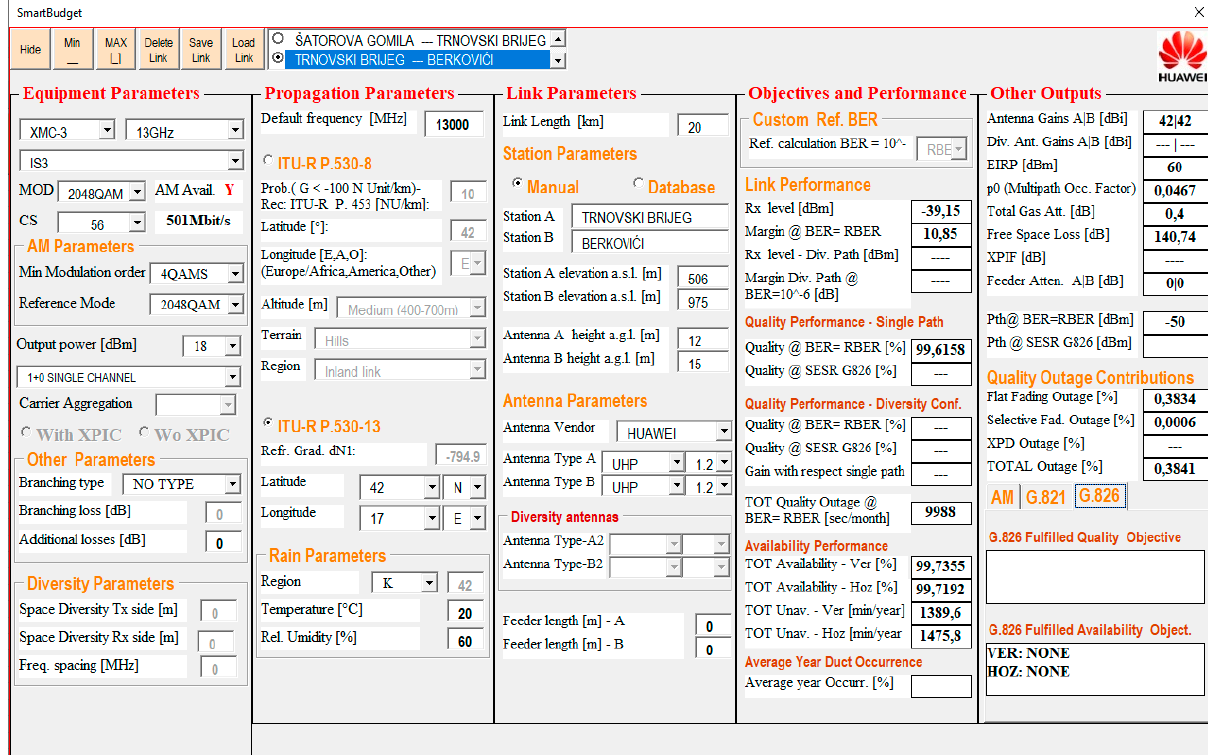
Figure 7. Prediction for the second RR section; 2048 QAM, 500 Mb/s.